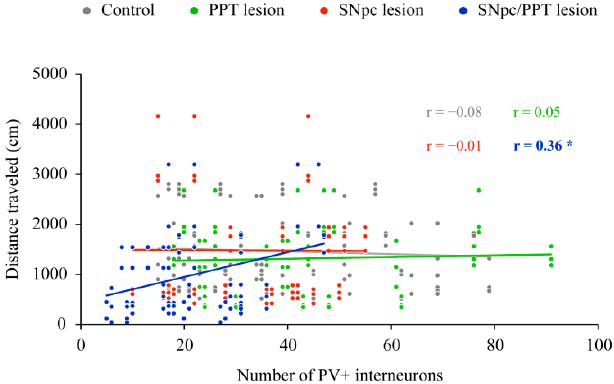
Figure 6. Functional coupling between the altered number of PV+ interneurons within DG and the spatial memory abilities in the distinct rat models of PD neuropathology. The significant positive correlation between the number of PV+ interneurons in DG and distance traveled during habitual response in the hemiparkinsonian rats with PD cholinopathy (SNpc/PPT lesion; n = 8) in contrast to no significant correlations in the control rats (Control; n = 6), the rats with PD cholinopaty (PPT lesion; n = 4) and hemiparkinsonian rats (SNpc lesion; n = 4). Bold numbers with * indicate the statistically significant correlations at p ≤ 0.05.